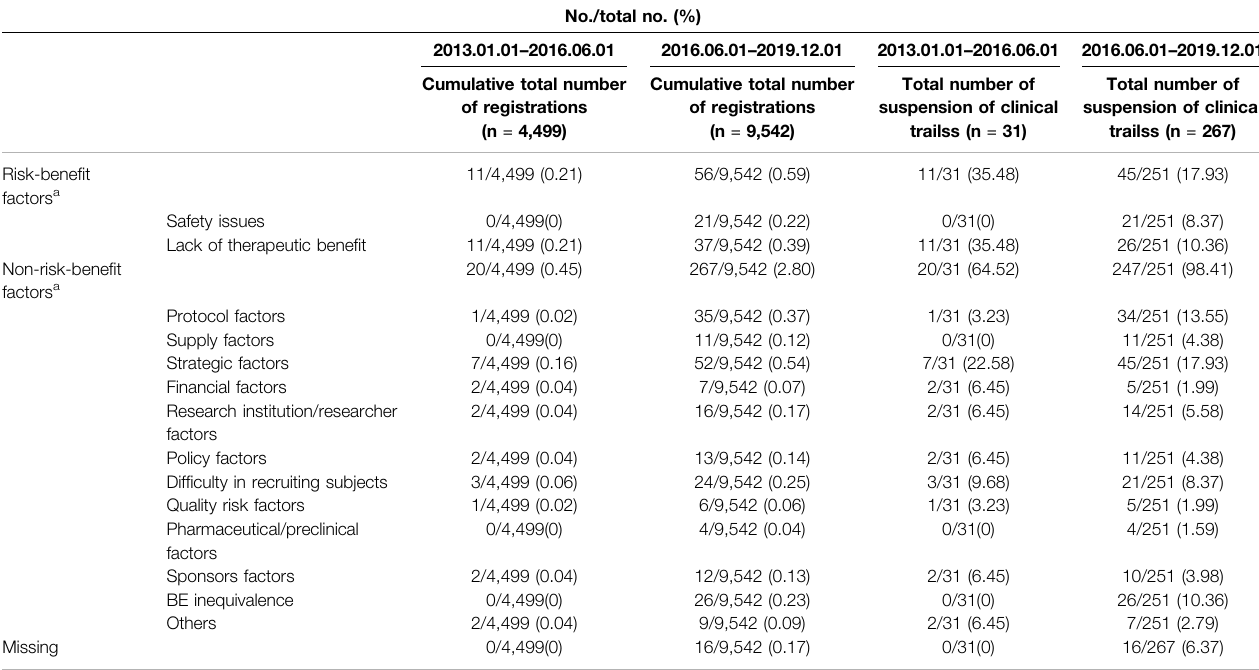
TABLE 3 | Trend analysis of the timeline of suspensions of clinical